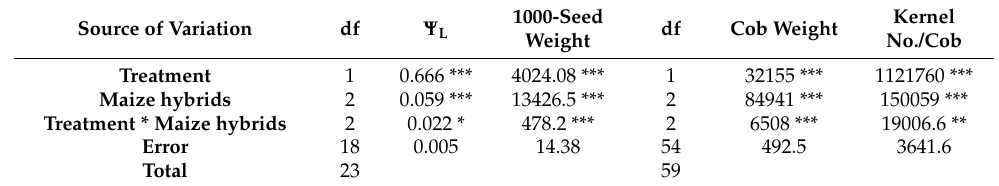
Table 4. Significance level from analysis of variance observed for leaf water potential (-MPa), 1000- seed weight, cob weight and number of kernels/cob of three maize ( Zea mays L.) hybrids when two-week-old plants were subjected to three cycles of drought stress.